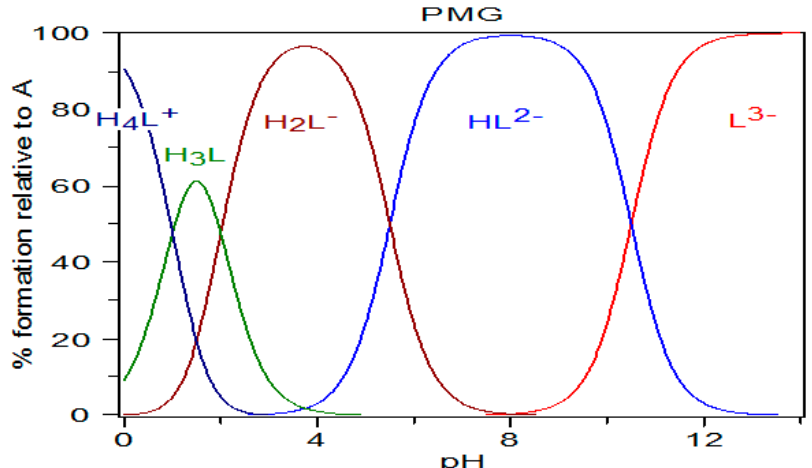
Figure 4. Diagram of PMG species distribution calculated using the pK a values of Appleton et al. [42] (pK a1 < 1; pK a2 = 2.0; pK a3 = 5.5; pK a4 = 10.5), and the HySS program (Alderighi et al., 1999) [47].